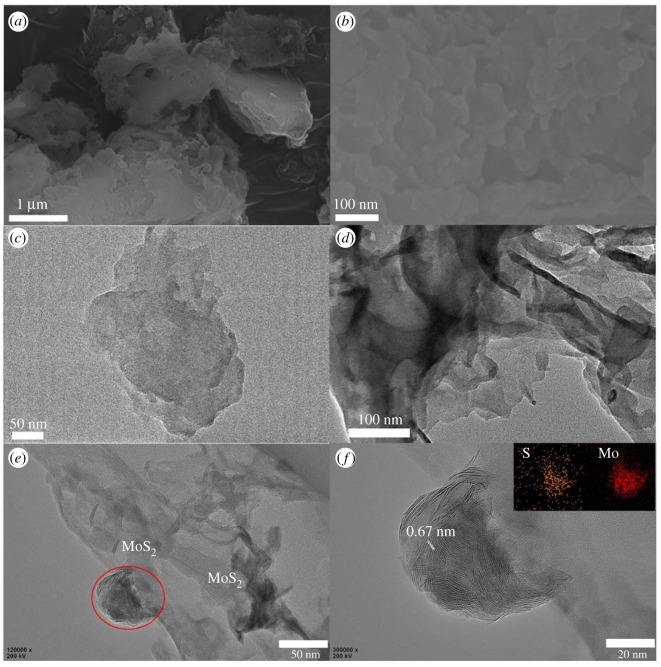
(a,b) SEM images of g-C3N4 and 1.25% MoS2. (c,d) TEM images of g-C3N4. (e) TEM image of 1.25% MoS2. (f) Magnified image of the area circled in red in (c). Inset of (f) is the corresponding elemental mapping of Mo and S elements.